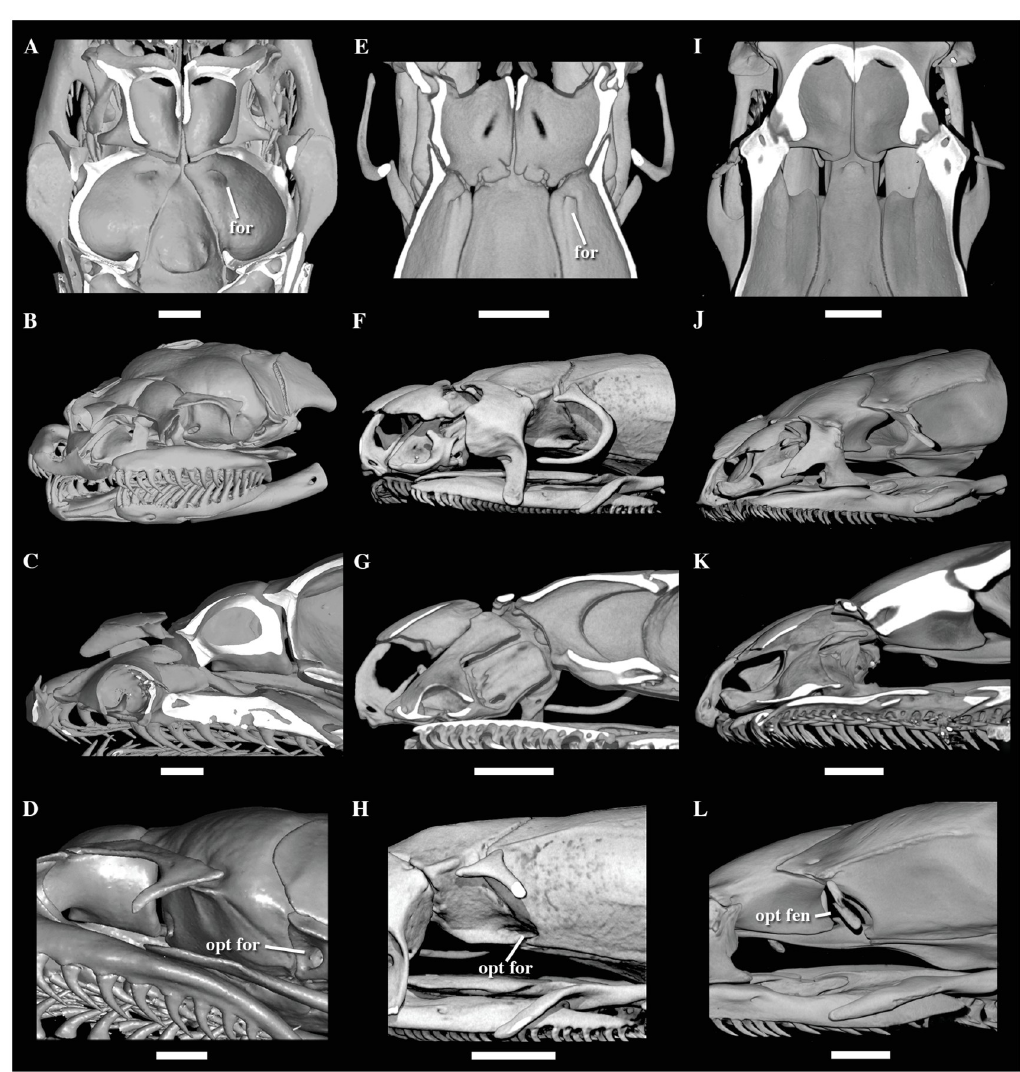
Fig 24. Skulls of Acrochordus granulatus (A-D), Fimbrios klossi (E-H), and Xylophis perroteti (I-L). Three-dimensional surface and cutaway views based on high resolution X-ray computed tomography. A, E, I, dorsal three-dimensional cutaway views along the frontal axis; B, F, J, oblique three-dimensional surface views; C, G, K, left lateral three-dimensional cutaway views along the sagittal axis; D, H, L, left lateral three-dimensional surface views. Legends: for ., optic foramina; opt . fen ., optic fenestra. Scale bar =